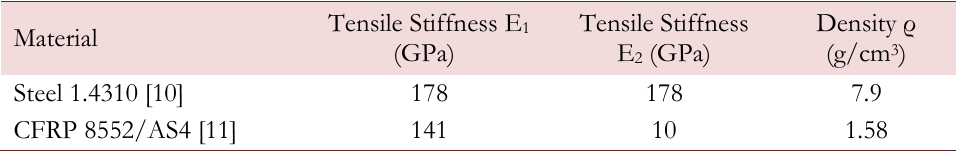
Table 1: Material properties.